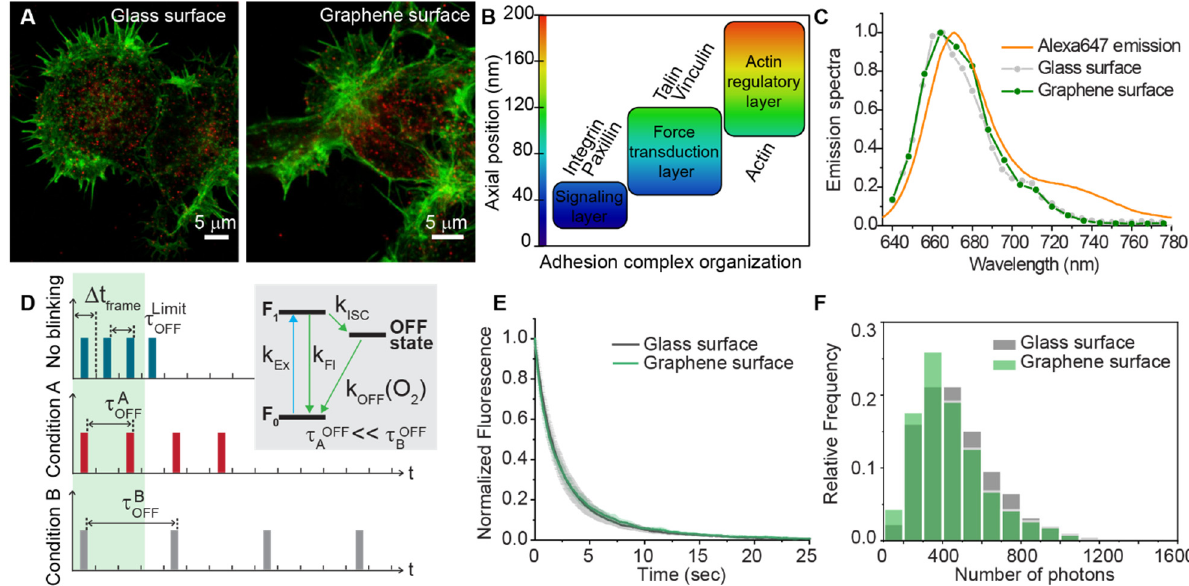
Figure 1. Substrate influence on single molecule detection. ( A ) Confocal imaging of DIV1 hippocampal neurons. Vinculin labeled with AlexaFluor647 (red), and F-actin stained with AlexaFluor488 (green). Scale bars: 5 µm. ( B ) FA protein organization into three functional layers and their distances from the substrate: vinculin resides within the intermediate force transduction layer. ( C ) Emission spectrum of vinculin-AlexaFluor647 on different substrates (glass and graphene) and theoretical Alexa 647 spectrum. ( D ) Scheme of the temporal evolution of the signal in a STORM recording, according to the ON/OFF ratio. Simplified sketch of the fluorophore photocycle (all the processes that influence the OFF state are grouped in a general OFF state with a global k OFF ). Three different cases are compared: sparse regime cannot be reached (i.e., no blinking) and sparse regime with short (condition A) and long (condition B) off time/residency, respectively. The green region represents the initial part of the STORM recordings, in which most of the molecules are pushed into the dark state to reach the required molecular sparsity. According to the characteristic on/off time, a different distribution of events in time will be registered, influencing the quantitative information extractable from the single-molecule recordings. ( E ) Decay of fluorescence upon 647 nm illumination on graphene and glass surface, and ( F ) number of emitted photons.